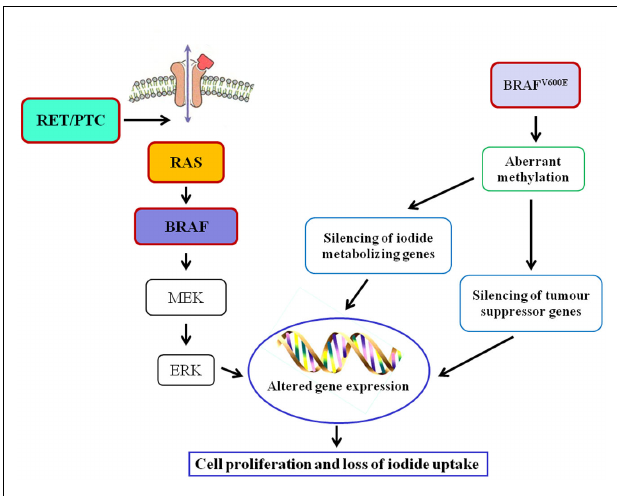
FIGURE 1 | Main genetic alterations and related epigenetic modifications in thyroid